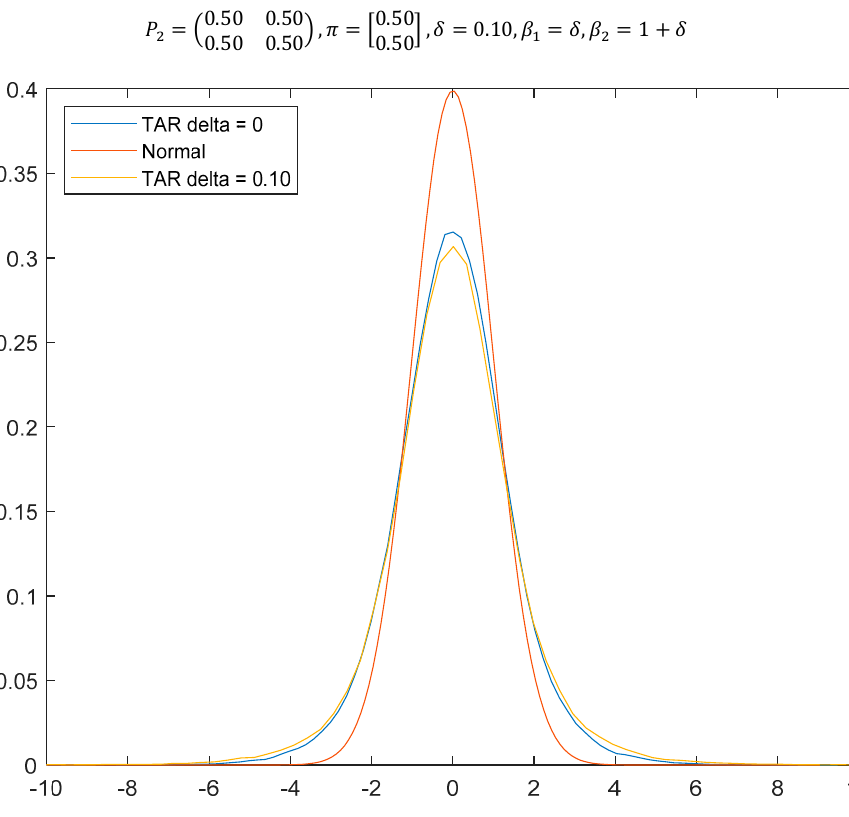
Figure 2. Simulated Distributions for TAR(1) with 𝑃 (cid:2870) as the transition matrix.